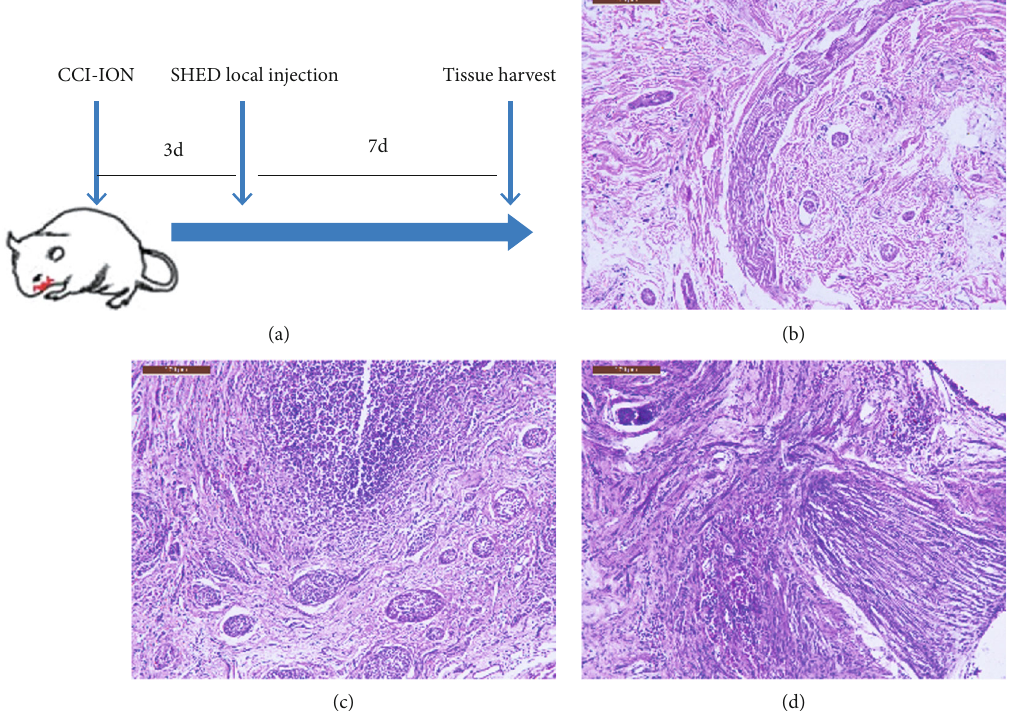
Figure 4: Local injection of SHED inhibits in fl ammatory cell in fi ltration in the injured nerve. (a) Scheme showing the timing of SHED transplantation and tissue collection. Hematoxylin-eosin staining revealed that the number of leukocytes recruited in the trigeminal nerve was signi fi cantly increased in the CCI-ION group (c) as compared with the sham group (b). In fl ammatory cell in fi ltration in the trigeminal nerve was decreased after local injection of SHED ( 1 × 10 5 cells, 0.2mL) (d). Scale bar = 200 μ m